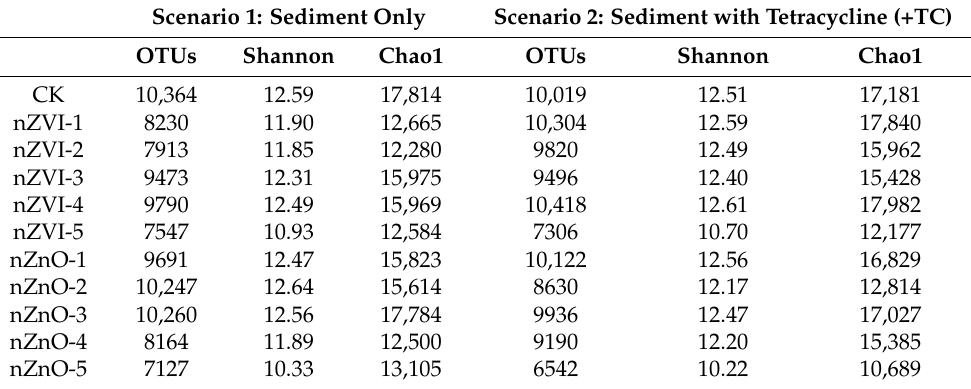
Table 2. Changes in bacterial OTUs, diversity, and richness index by nanoparticle addition in sediment with or without tetracycline. Scenario 1: Sediment Only Scenario 2: Sediment with Tetracycline (+TC) OTUs Shannon Chao1 OTUs Shannon